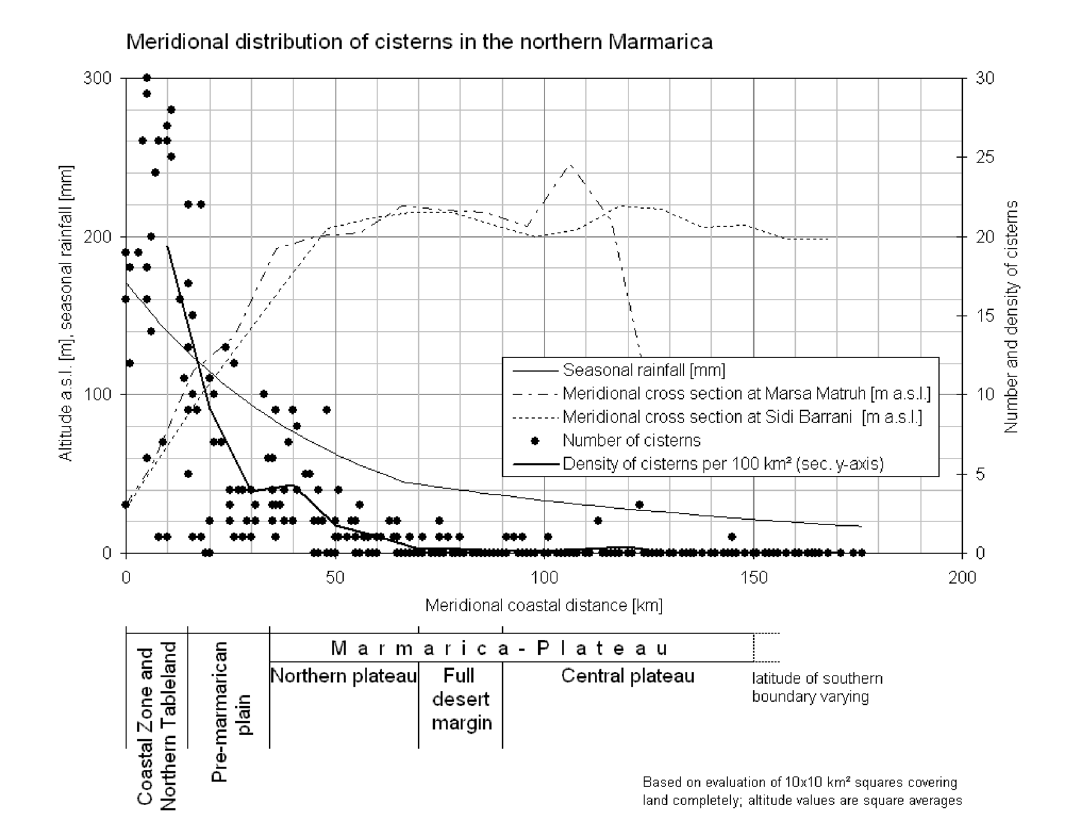
Fig. 2. Distribution of cisterns on the Marmarica-Plateau in relation to annual rainfall and relief. The density of cisterns between the coast and the Central Marmarica-Plateau decreases with the beginning of the Pre-Marmarican plain. (Thomas Vetter).